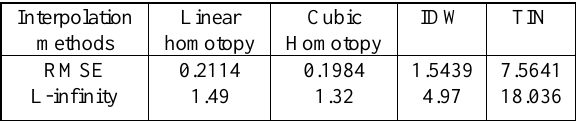
Table 1. Accuracy of interpolation methods in term of RMSE and L-infinity 6.